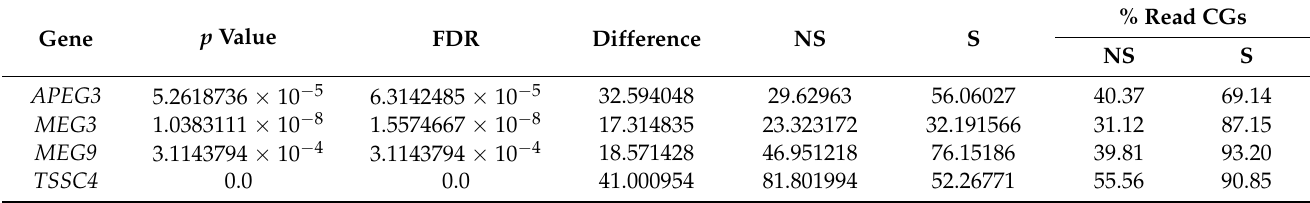
Table 2. Significantly different ( p < 0.05) percentages of methylation in non-stimulated (NS) and